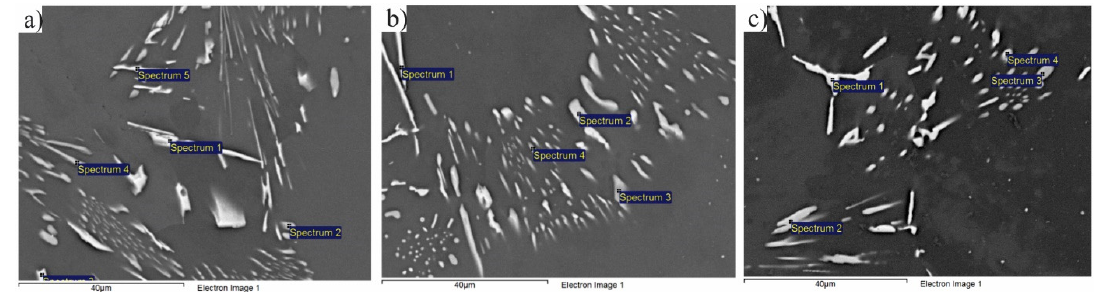
Figure 7. SEM (scanning electron microscope) micrographs of the as-cast sample ( a ), and the samples homogenized for 6 h ( b ) and 12 h ( c ) at a temperature of 580 °C, wherein EDS (energy dispersion spectrometer) analysed spots are marked. Table 3. EDS results showing different phases present in the investigated samples from Figure 7 in at. %.